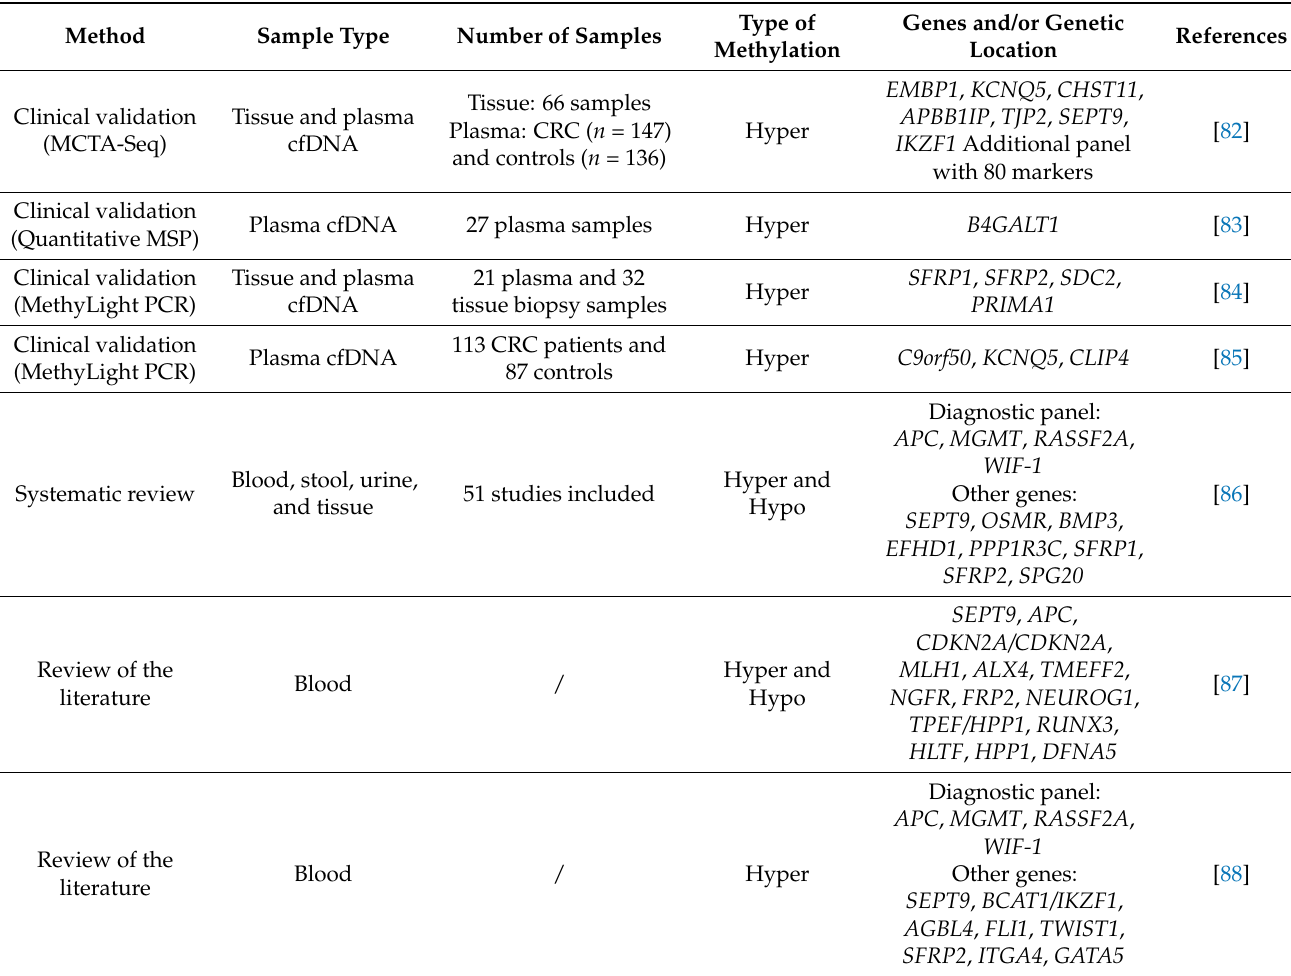
Table 3. An overview of methylation biomarkers for CRC in liquid biopsy. CRC: colorectal cancer; cfDNA: cell-free DNA; MCTA-Seq: methylated CpG tandems amplification and sequencing; MSP: methylation-specific polymerase chain